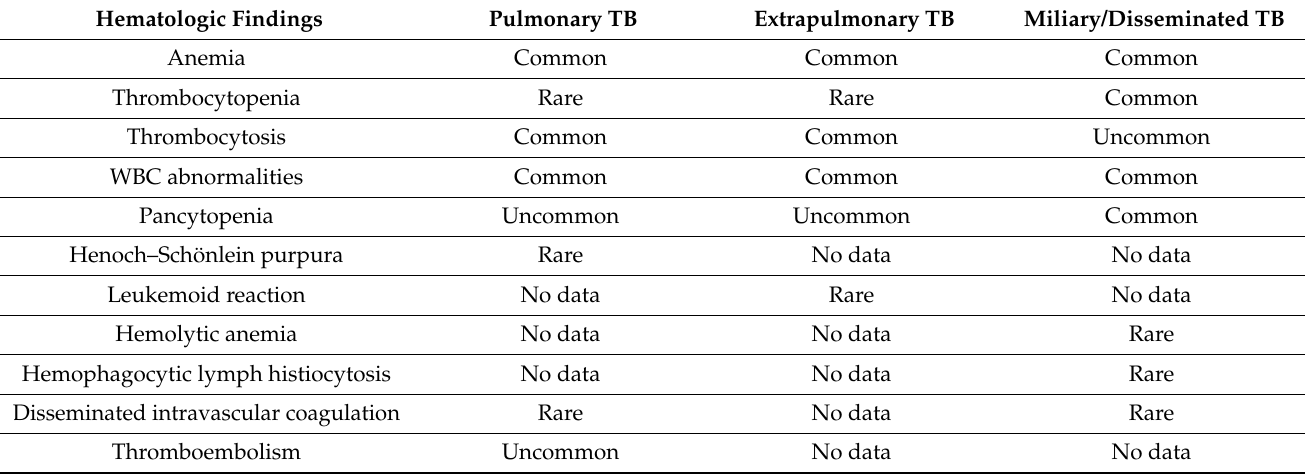
Table 1. Frequency of hematologic patterns in TB